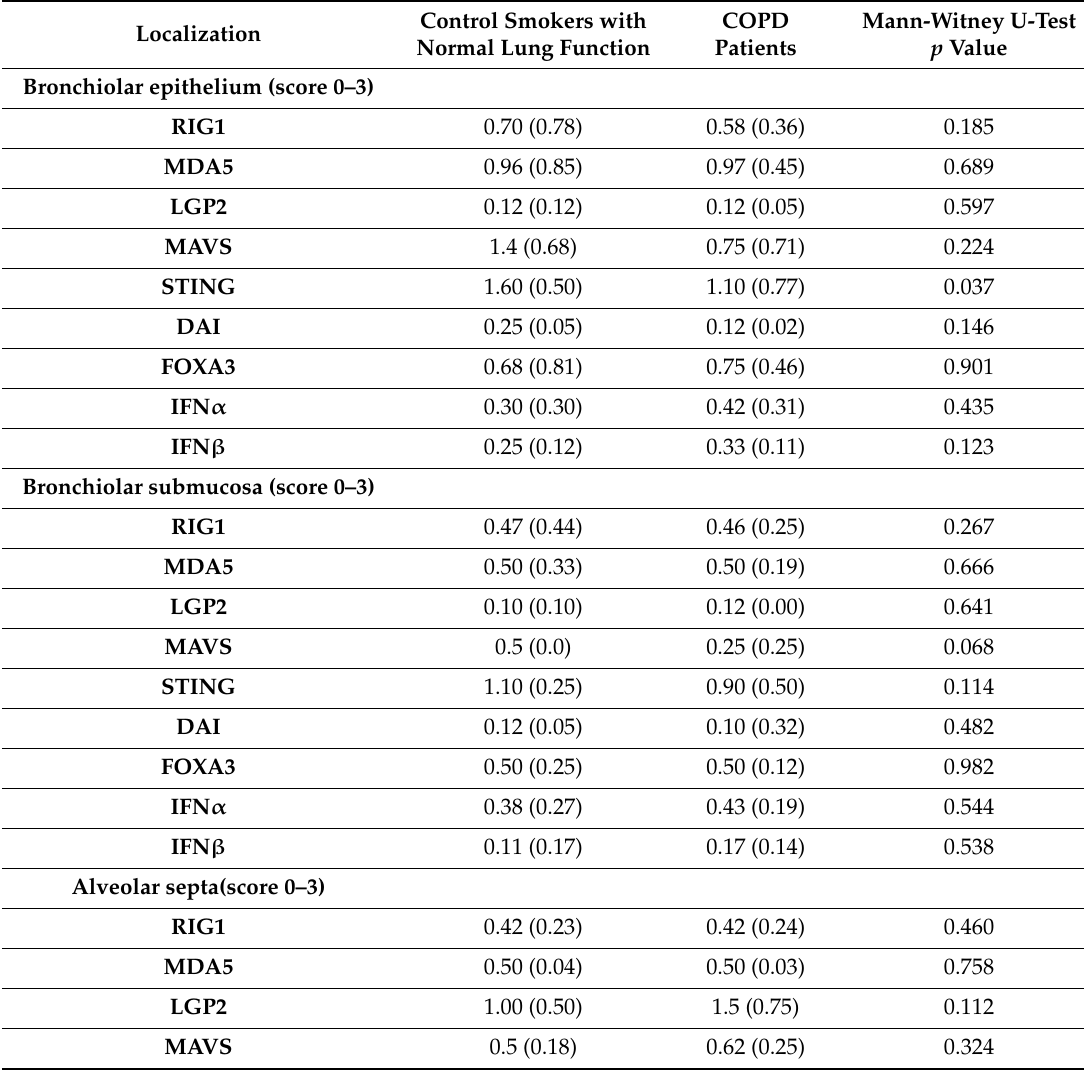
Table 4. Immunohistochemical quantification of selected viral-related innate immune molecules and cytokines in the peripheral